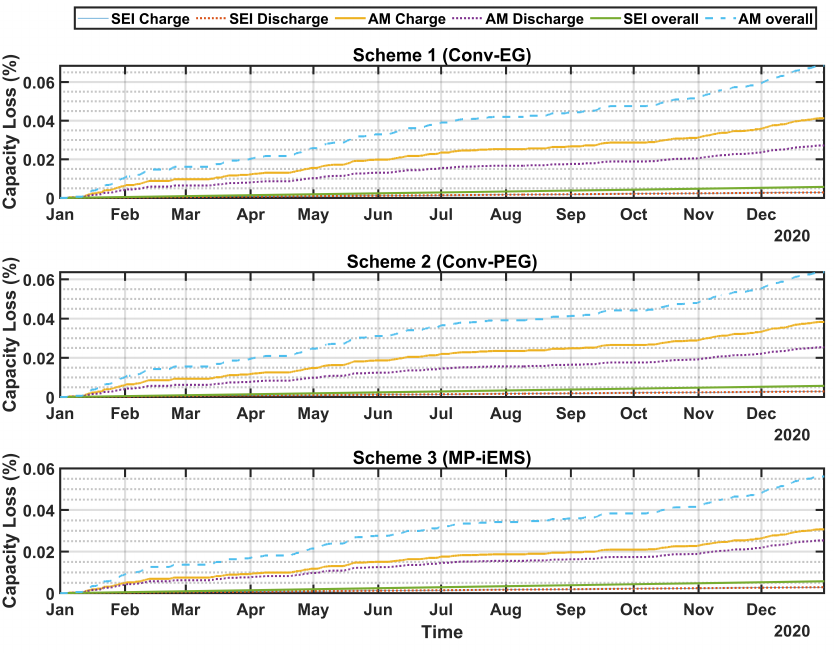
Figure 22. Comparison of various capacity losses among different